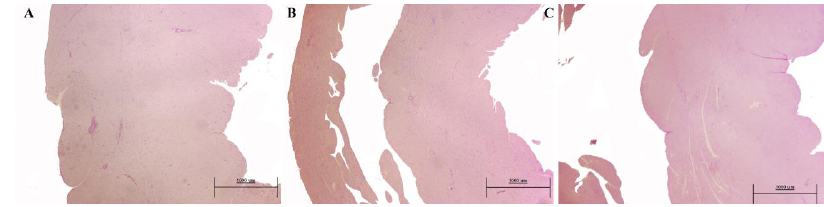
Figure 4. Representative images of modification in interventricular heart septum thickness. ( A ) from